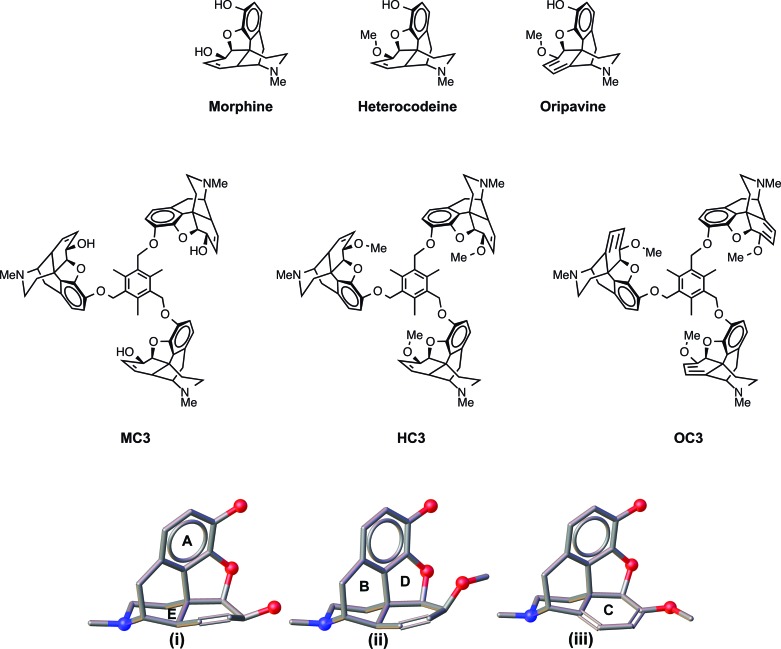
Molecular structures of morphine, heterocodeine and oripavine along with C3-symmetic opioid molecules developed in this study: morphine (MC3), heterocodeine (HC3) and oripavine (OC3). Left to right, morphine, heterocodeine and oripavine scaffolds. Structures (i), (ii) and (iii) show the geometries of each scaffold (morphine, heterocodeine and oripavine respectively), with labeled ring substituents A–E, modified from X-ray structures reported in the CSD.